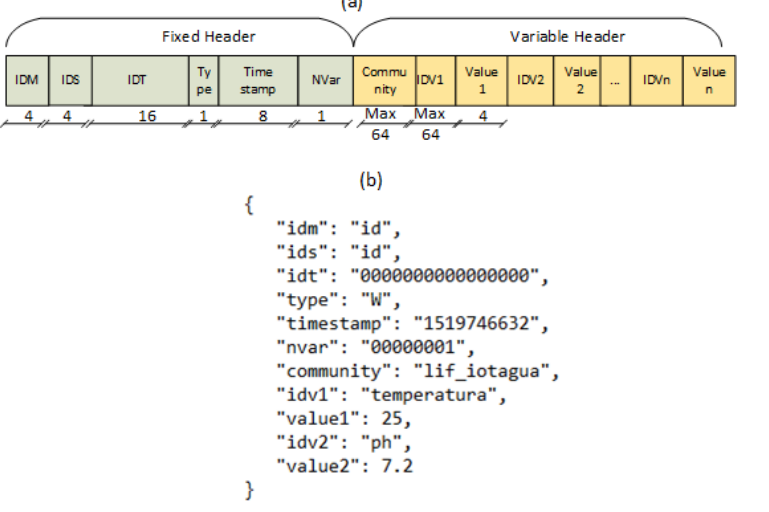
Figure 4. ( a ) Message format; ( b ) example of an IoTCocoa JSON message